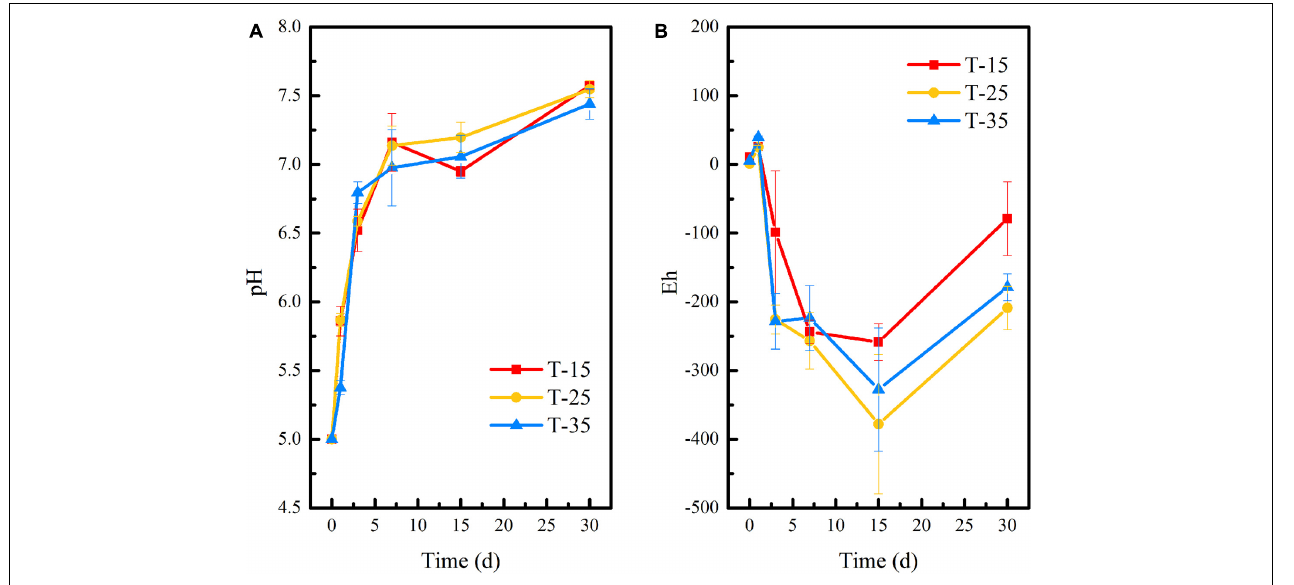
FIGURE 4 | Changes of (A) pH and (B) Eh during the microbial stabilization process of SRB-PSB under different